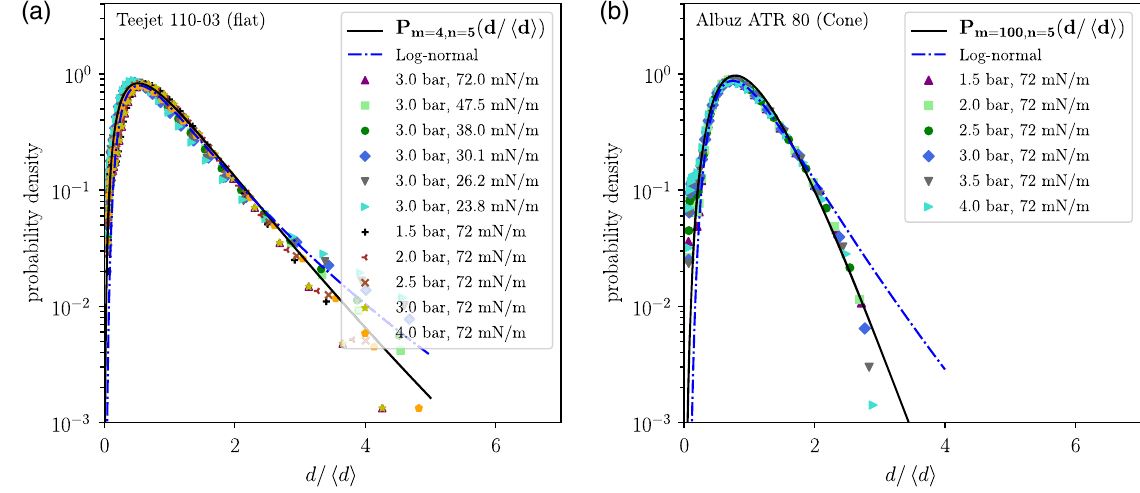
FIG. 8. The rescaled droplet size distributions of pure water for various pressures and water ethanol mixtures for the Teejet 110-03 nozzle (flat liquid sheet) (a) and the Albuz ATR 80 (conical liquid sheet) (b). The data collapse shows that one can change the mean (or median) droplet size by changing the surface tension or pressure, without altering the overall shape of the distribution, but that the shape depends on the type of nozzle [see dashed line in (b) for comparison]. Fit lines show that the distributions can be well fitted by the global size distribution [Eq. (11)] and fit parameters indicate that the conical nozzle produces ligaments of equal size, in contrast with the flat nozzle with a broad distribution of ligament